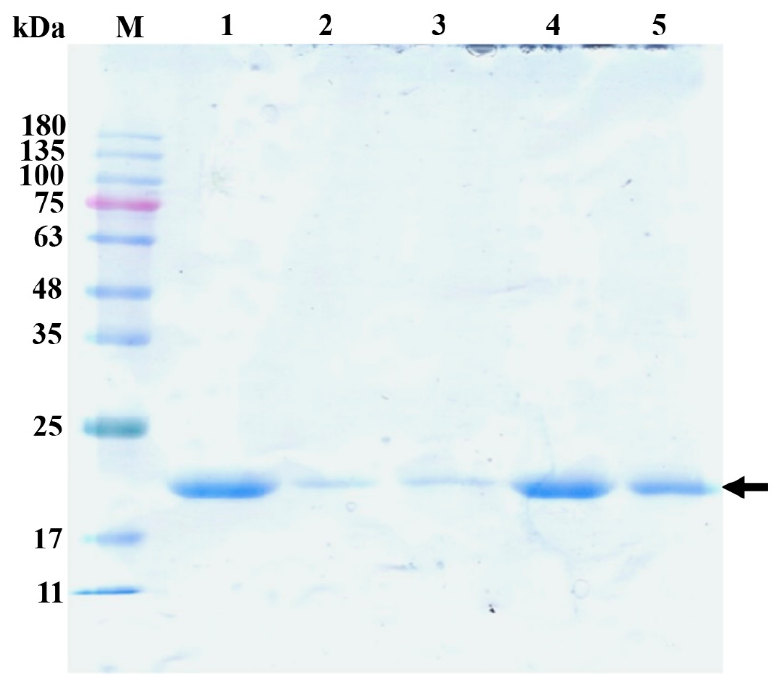
Figure 9. SDS–PAGE analysis of in vitro release assays. After 1 (lanes 2 and 3) and 6 (lanes 4 and 5) days, pIL-1 β was released from alginate MPs (lanes 2 and 4) and chitosan-coated alginate MPs (lanes 3 and 5) compared to 5 µg of pure pIL-1 β (lane 1). Lane M, electrophoretic molecular mass markers. The arrow indicates the pIL-1 β .